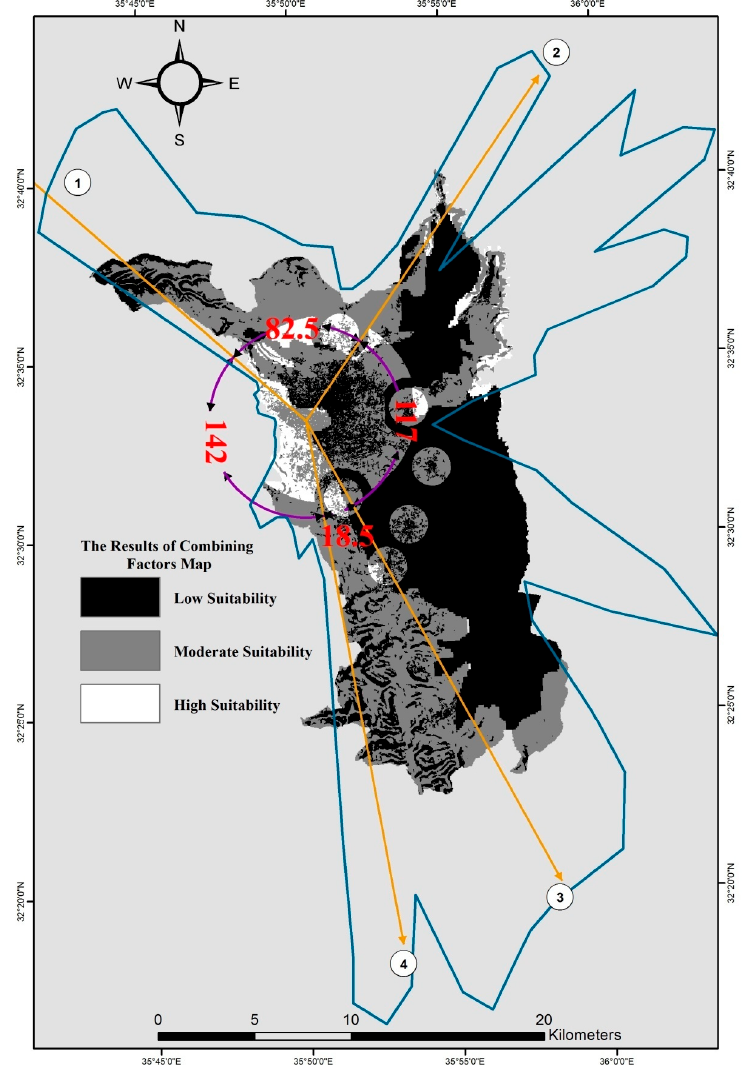
Figure 15. The result of suitability analysis overly and TDNN prediction for 2025. Line color representation: blue is the expected urban growth extent, yellow are the lines delimiting the preferred angle of growth between the arrows 1&2 and 3&4. Delimited angles between 2&3 and 1&4 define the unwanted growth direction avoiding fertile soils (117 ◦ ) and rugged terrains (142 ◦ )